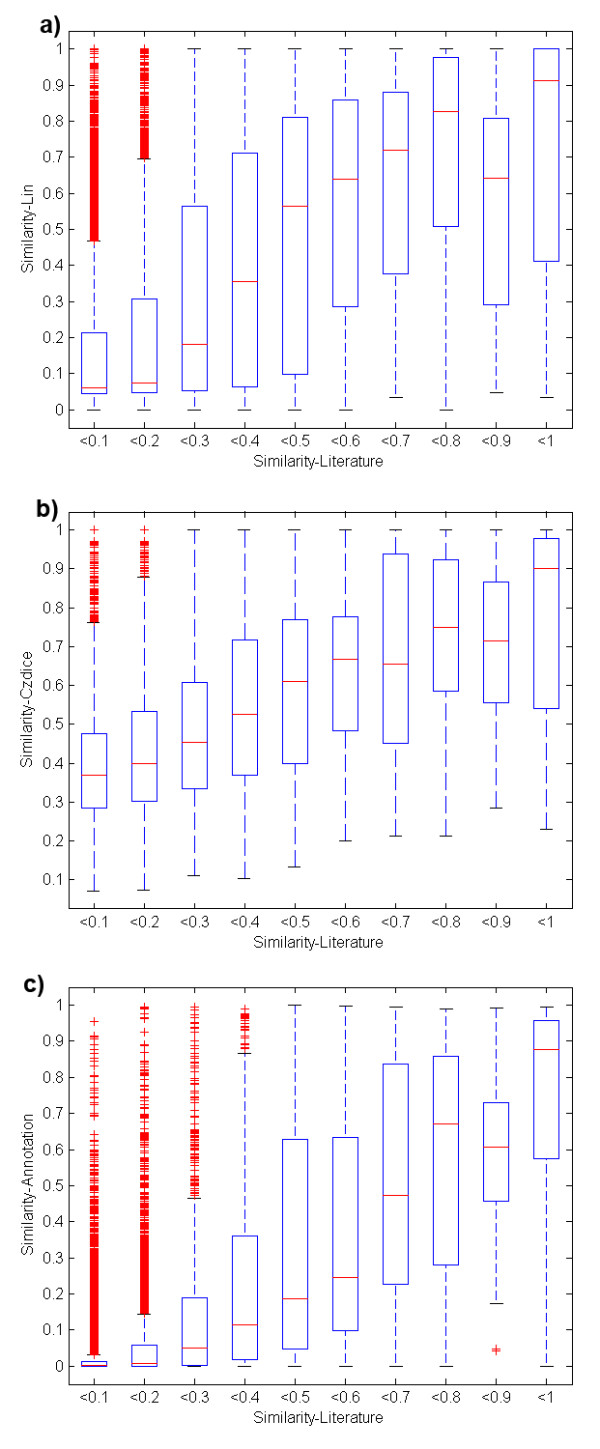
Comparison of literature similarity with other metrics. Literature-based similarity boxplot against evaluation metrics. X-axis corresponds to groups of biological process pairs categorized by their literature-based similarity (shown in increasing binned values). Y-axis corresponds to ontology-based similarity computed as a) Lin similarity, b) Czekanowski-Dice similarity, and c) Genome annotation similarity. Boxes expand from lower to upper quartile values, and contain a red line corresponding to median value. Dashed lines extend-ing from each end of the box show the extent of the rest of the data (with a maximum length of 1.5 units of interquartile range). Outliers, data with values beyond the ends of the whiskers, are marked as red crosses.